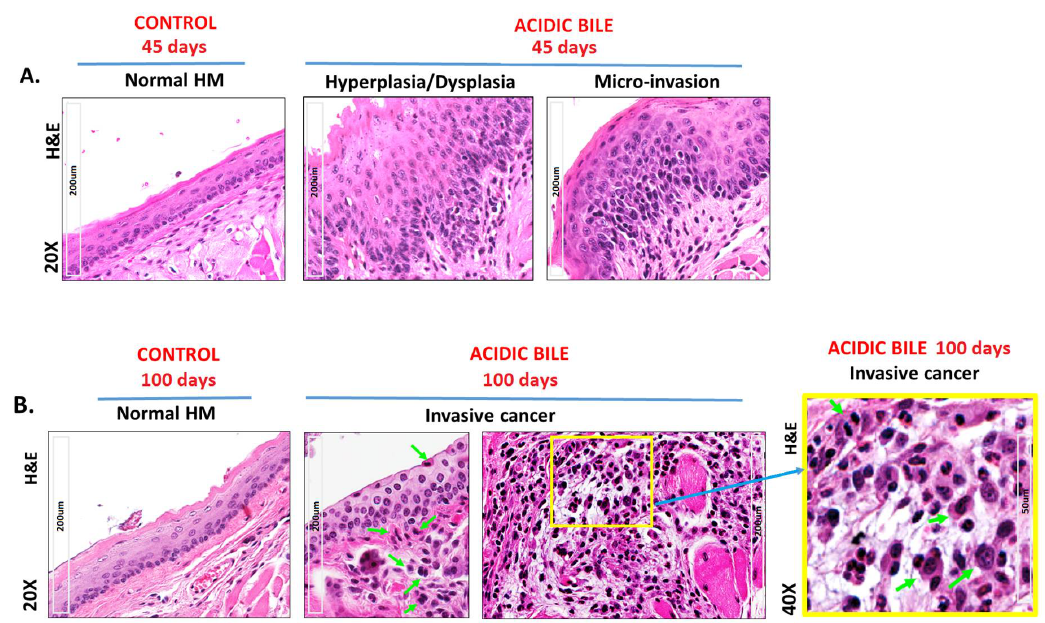
Figure 1. Acidic-bile-induced malignant transformation in the murine hypopharyngeal mucosa (HM) of C57Bl/6J mice (H&E staining) after 45 days and 100 days of exposure (from left to right). ( A ) The 45 days of exposure. Normal HM—keratinized stratified squamous epithelium/single layer of basal cells; hyperplastic/dysplastic HM—the thickness of the stratified epithelium and hyperchromatic or pleiomorphic basal cells extended into the upper layers of the mucosa with mitotic figures seen throughout the depth of mucosa; severe dysplasia/micro-invasion—architectural changes extended into the upper levels of the mucosa, with mitotic features evident throughout the depth of the mucosa. Submucosal invasion by basal cells while maintaining full-thickness nuclear hyperchromatism without surface maturation. ( B ) The 100 days of exposure. Normal HM—keratinized stratified squamous epithelium/single layer of the basal cells; invasive carcinoma—a representative malignant phenotype of atypical neoplastic cells in the submucosa characterized by large oval nuclei with abundant mitotic figures (arrows).